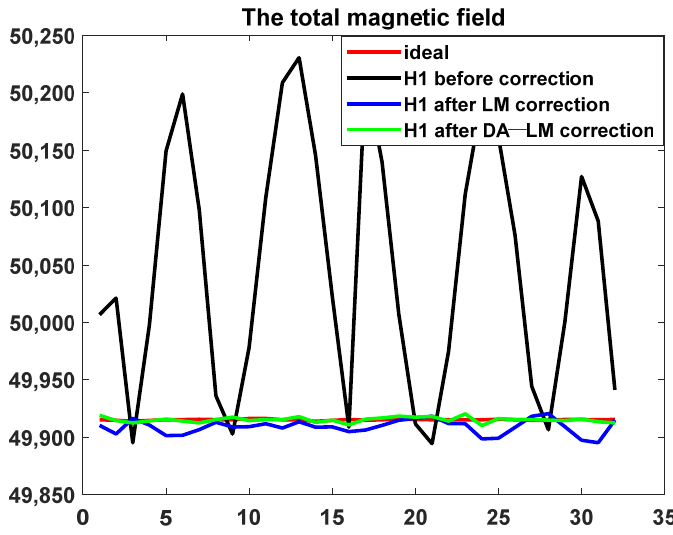
Figure 6. The experiment platform with the three-axis magnetometer MAG648.